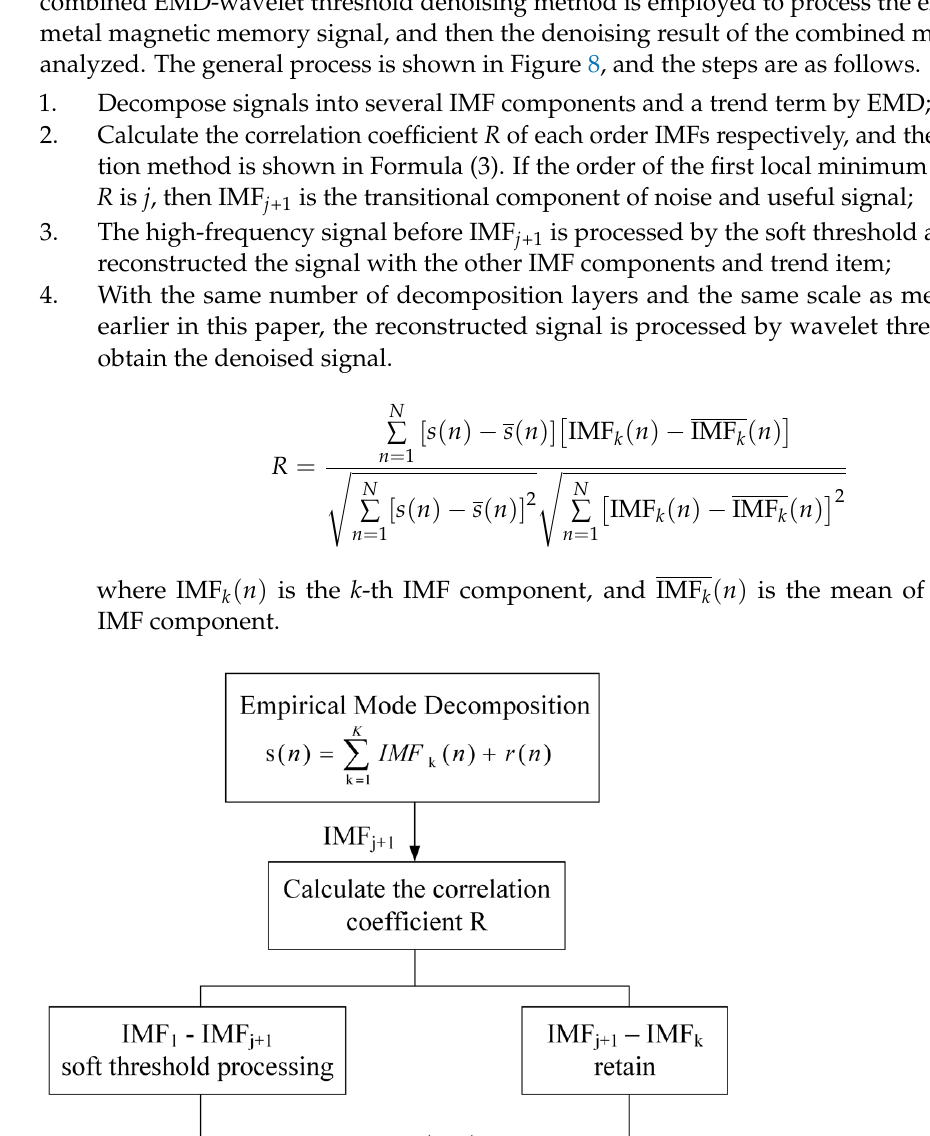
Table 1. Cross-correlation coefficient of IMF components of each magnetic field component signal.